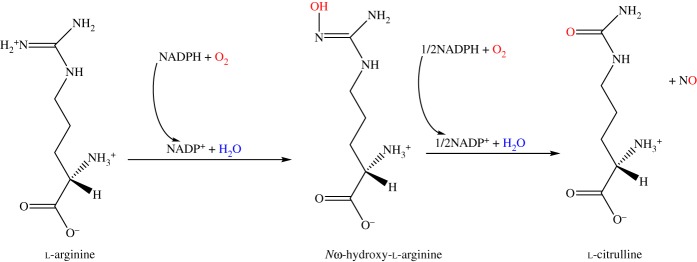
Production of NO by NOS enzymes [362].